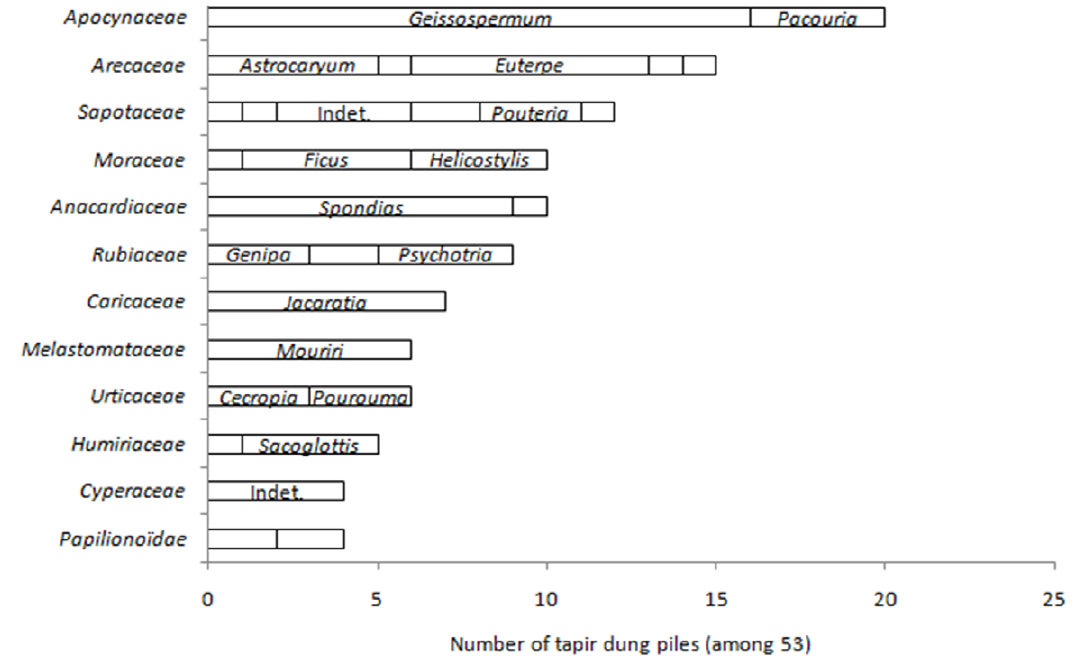
Figure 4. Frequency of most recurrent fruit taxa found in tapir dung piles from the Nouragues Reserve. We indicated families and genera found in more than four and three dung piles respectively. The length of each segment is proportional to the frequency of the considered genus.